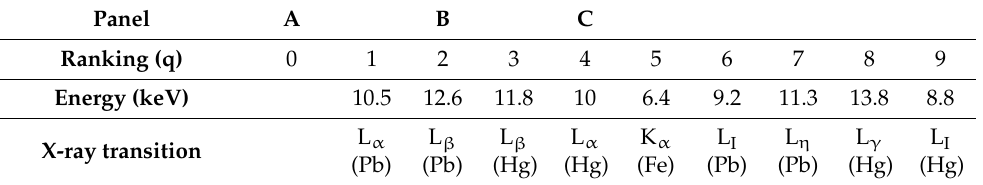
Figure 5. The sets of similarity maps, [ A ] , for the reference panel obtained following the incidence criterion. The numbers within the panels refer to Table 1, the letters to Table 4. The color bar illustrates the level of similarity (in terms of the angle between vectors). ( A ) shows [ A ] , the set of similarity maps obtained without manipulating the spectra. ( B ) shows [ A ] , obtained after that the channels around 12.6 and 10.5 keV have been suppressed. ( C ) shows [ A ] , the 11.8 and 10 keV series have been removed too. Table 4. The principal energies (i.e., elements’ emission series) emerging from the GS evaluated from the reference panel data. The series has been ordered following the incidence criterion: the first position is occupied by the series, which, if removed, generates a similarity change of more than 10% with respect to the value of [ A ] involving the largest number of pixels; the second place is held by k 0 the series which involves the second larger number of pixels and so on. The energy of the emission has been reported in keV and classified according to the X-ray nomenclature. The letters refer to Figure 5 and specify the series that have been removed before the calculation of the corresponding set of similarity